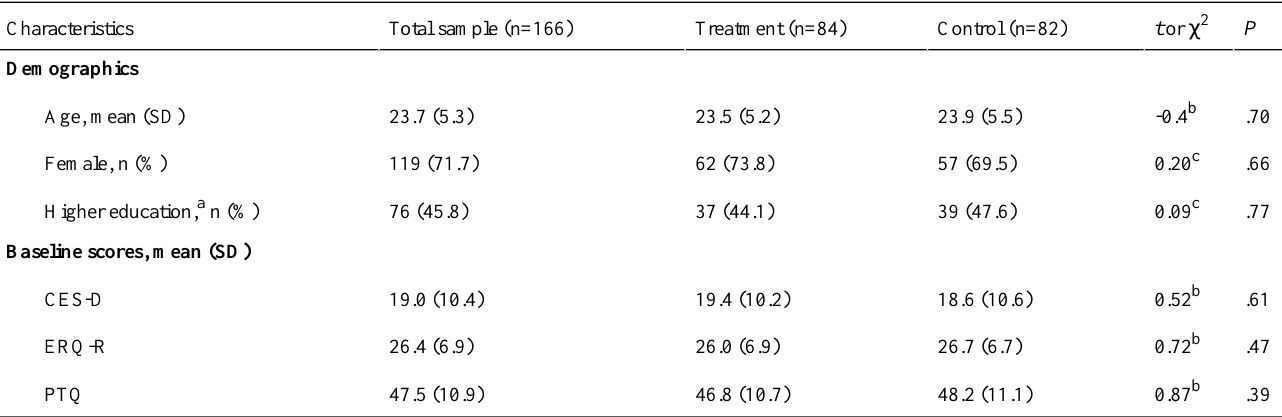
Table 1. Baseline characteristics of the